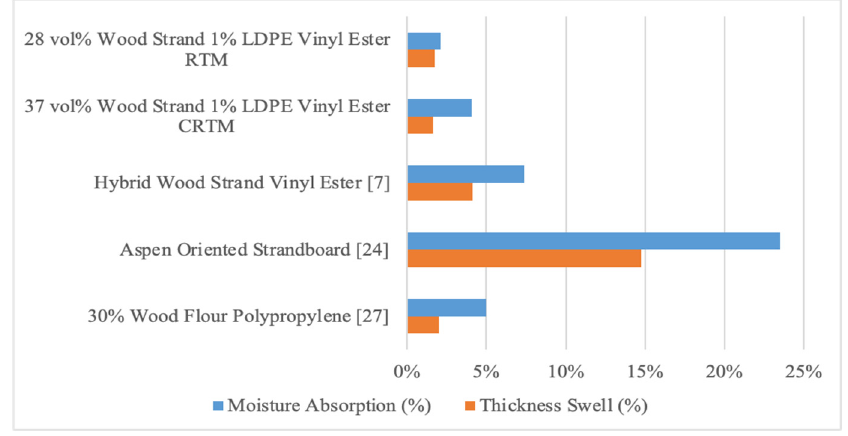
Figure 15. Moisture absorption and thickness swell behavior of RTM and CRTM wood strand panels compared to other panels from published data ([7,24,27]).